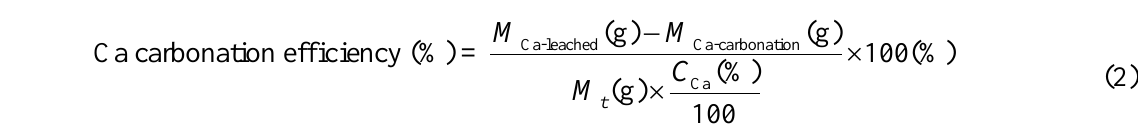
Solvent Solid dosage